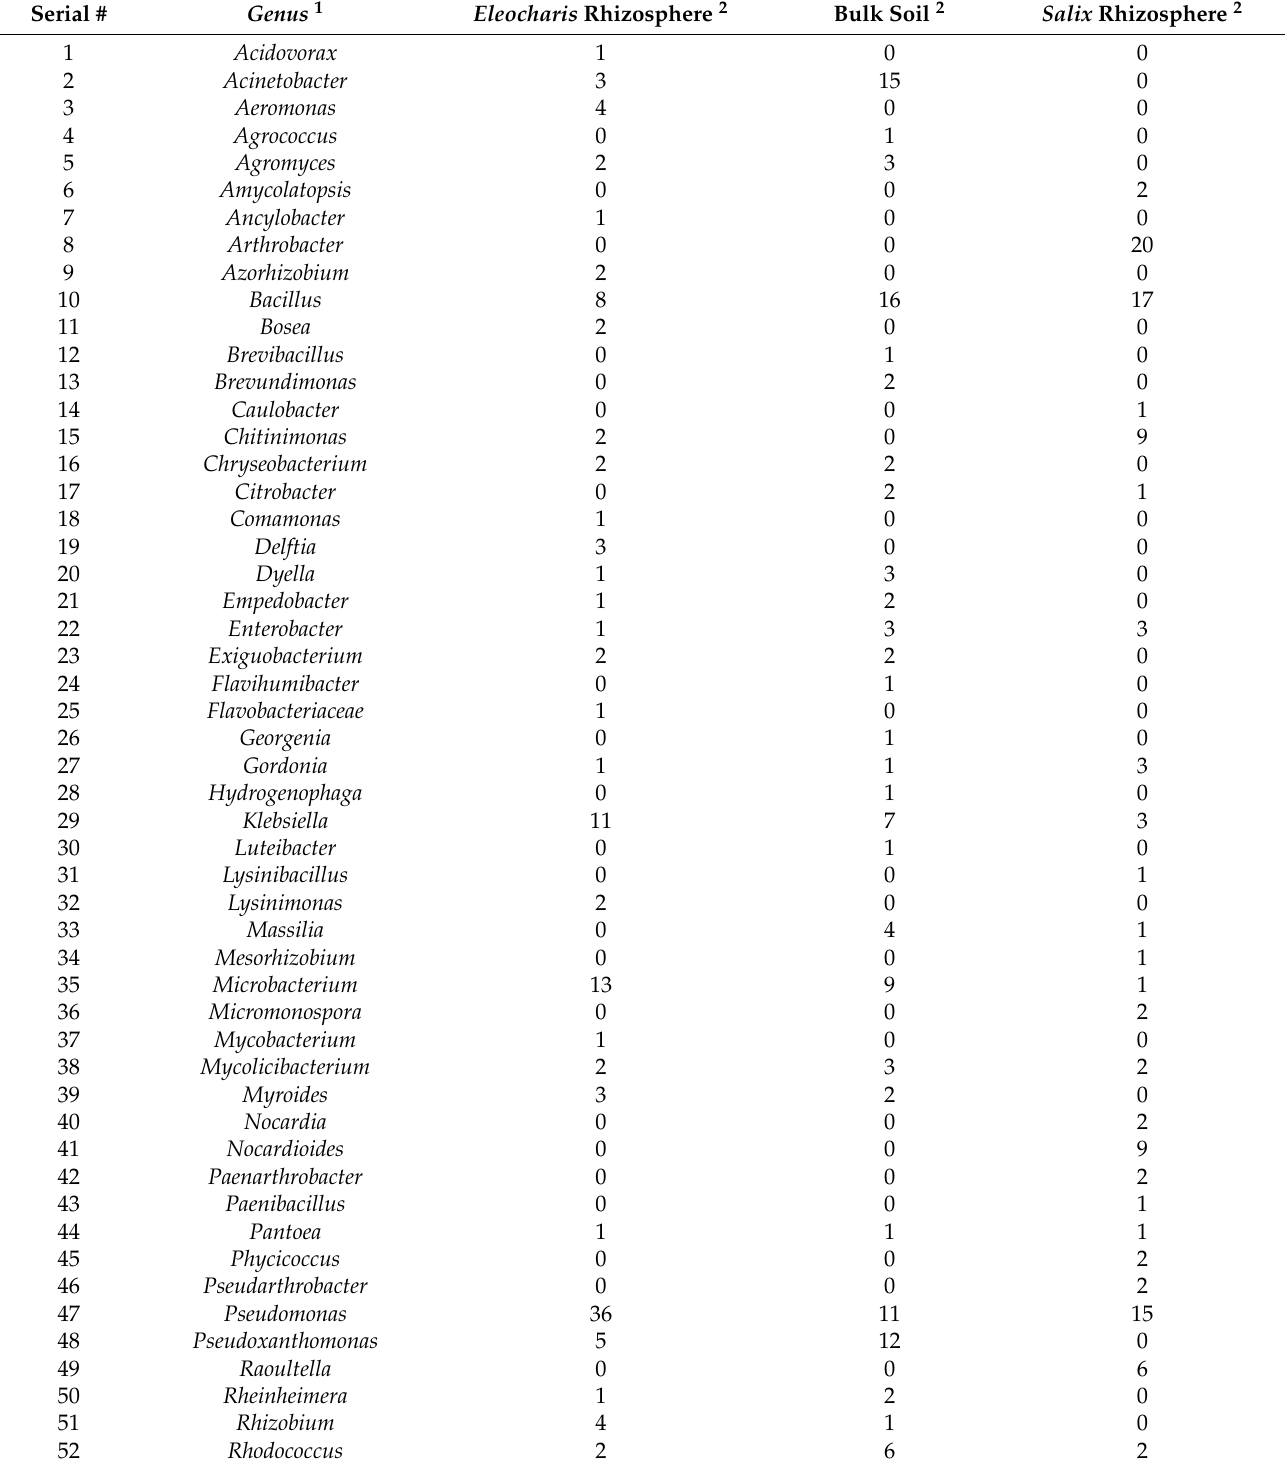
Table 1. Number of isolates belonging to each bacterial genus associated with S. purpurea rhizosphere, E. obtusa rhizosphere and bulk soil